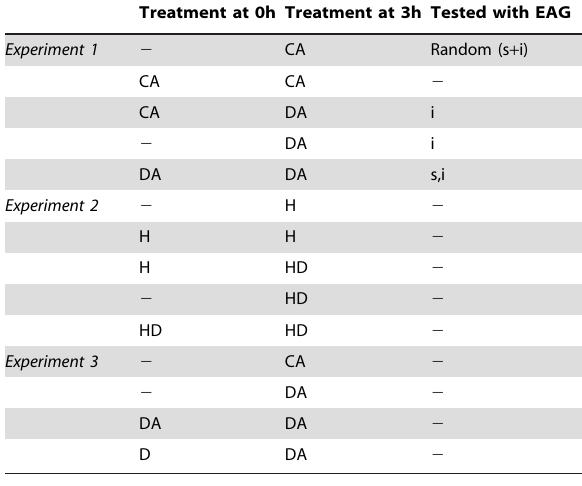
Table 1. Description of experiments and the treatments tested with female Aedes aegypti mosquitoes.